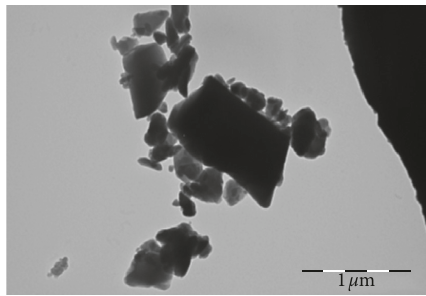
Figure 2: TEM observation of ground waste expanded perlite. Table 3: Content of active oxides in relation to the perlite grain